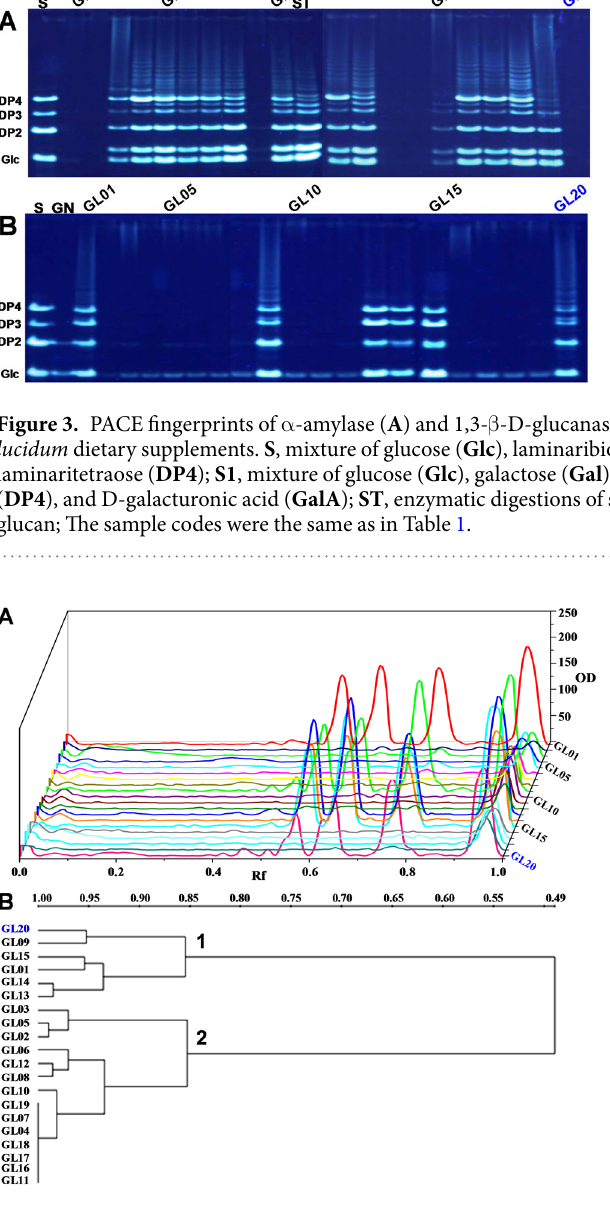
Figure 4. The digital scanning chromatograms ( A ) for PACE fingerprints of 1,3- β -D-glucanase digested polysaccharides and their dendrograms of hierarchical clustering analysis ( B ). Sample codes were the same as in Table